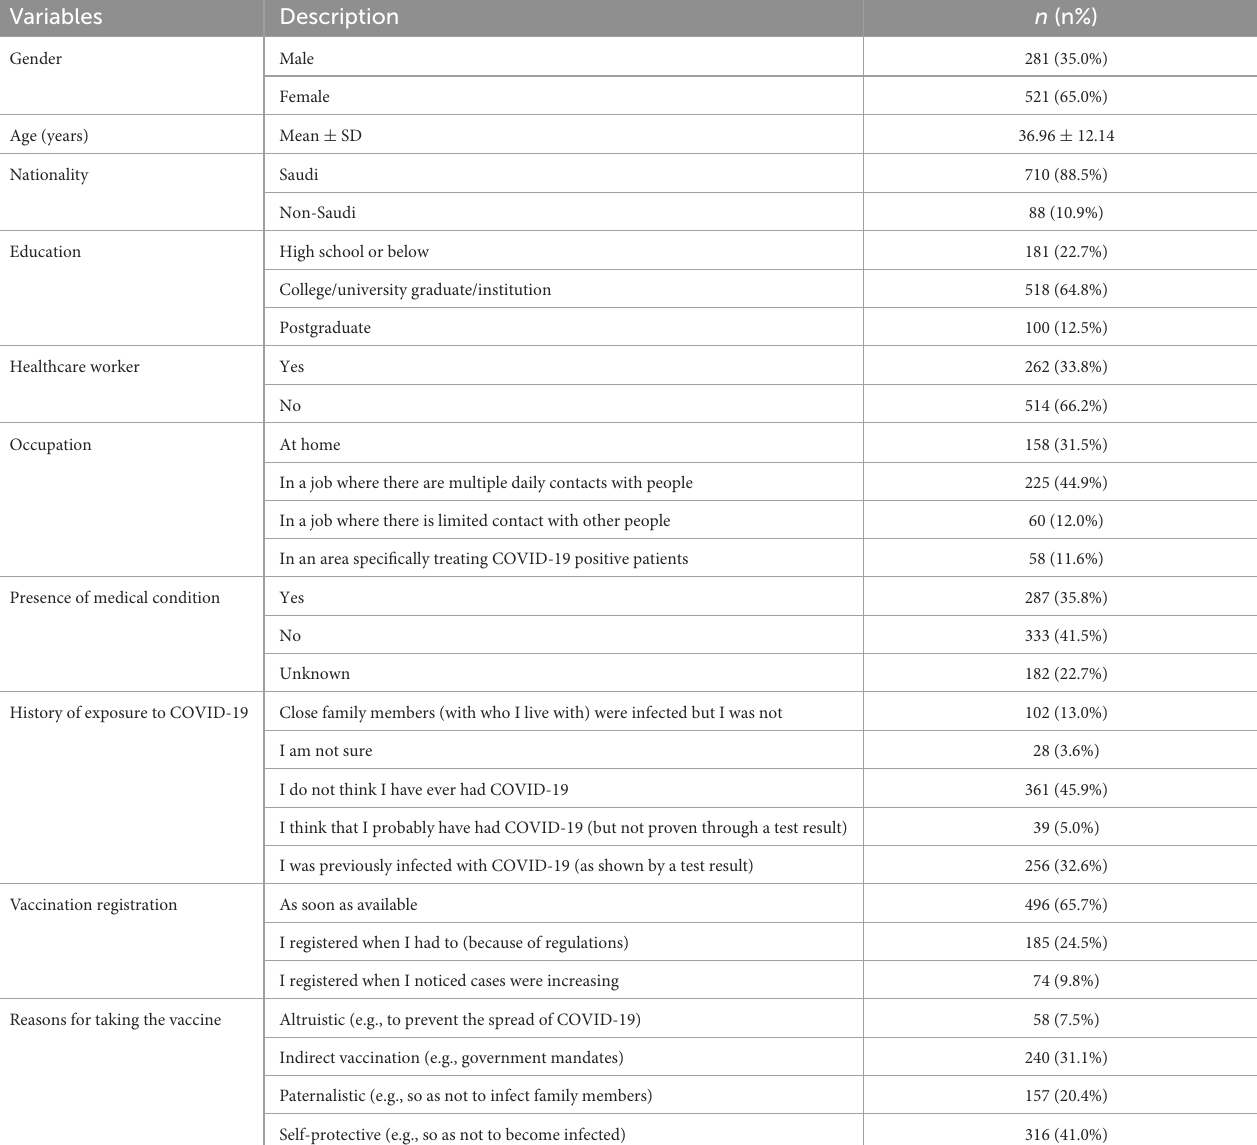
TABLE 1 Demographic and clinical characteristics of the study participants (n = 802).